Question: Which visualization type does this figure use?
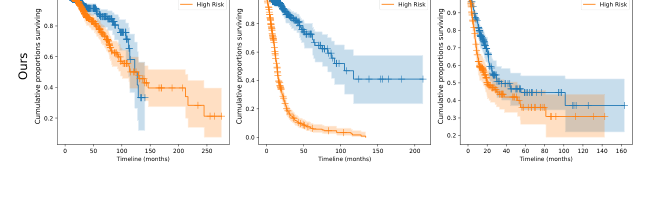
Answer: survival